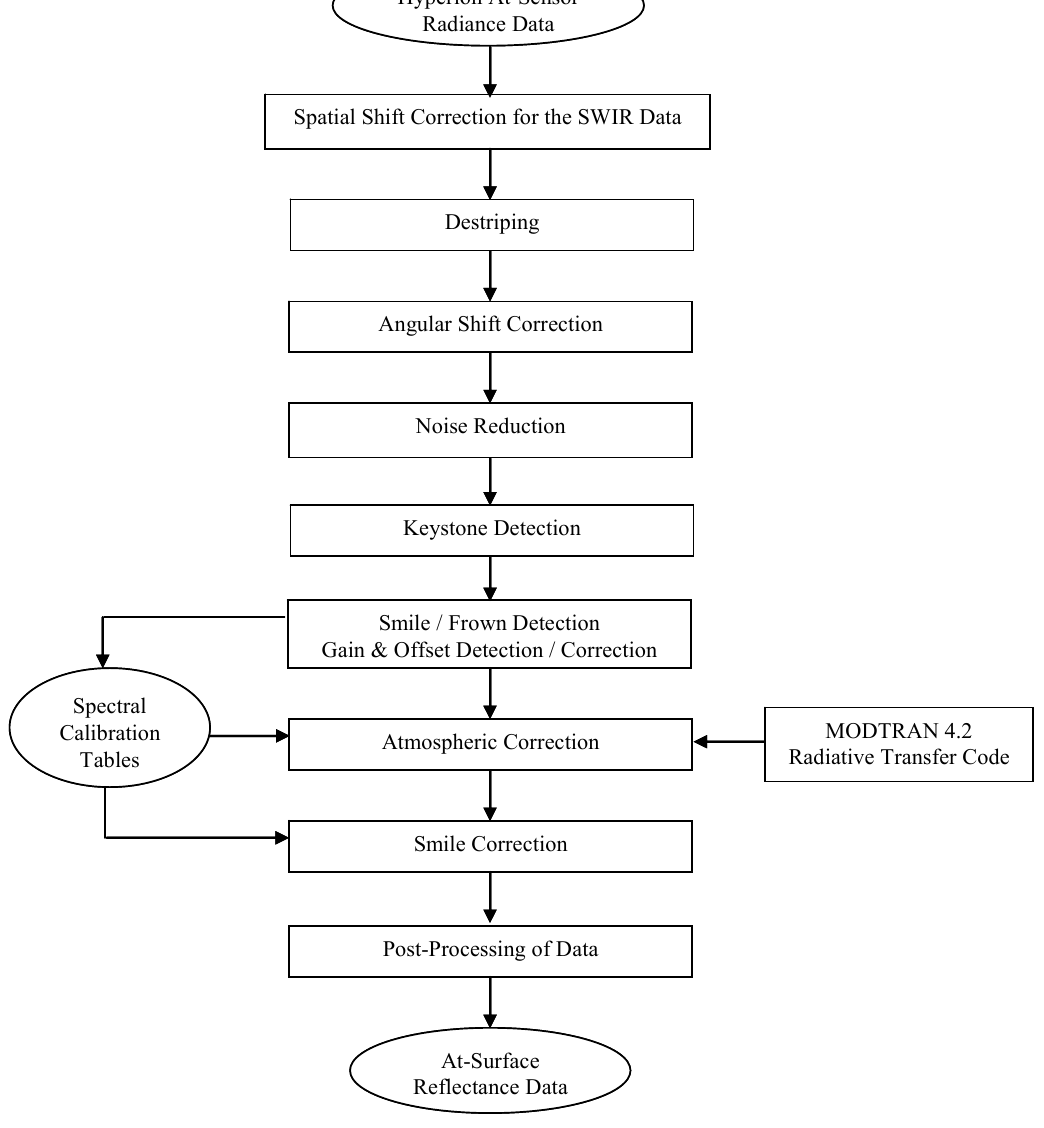
Figure 3. Hyperspectral data (Hyperion EO-1) pre-processing steps for retrieval of surface reflectance